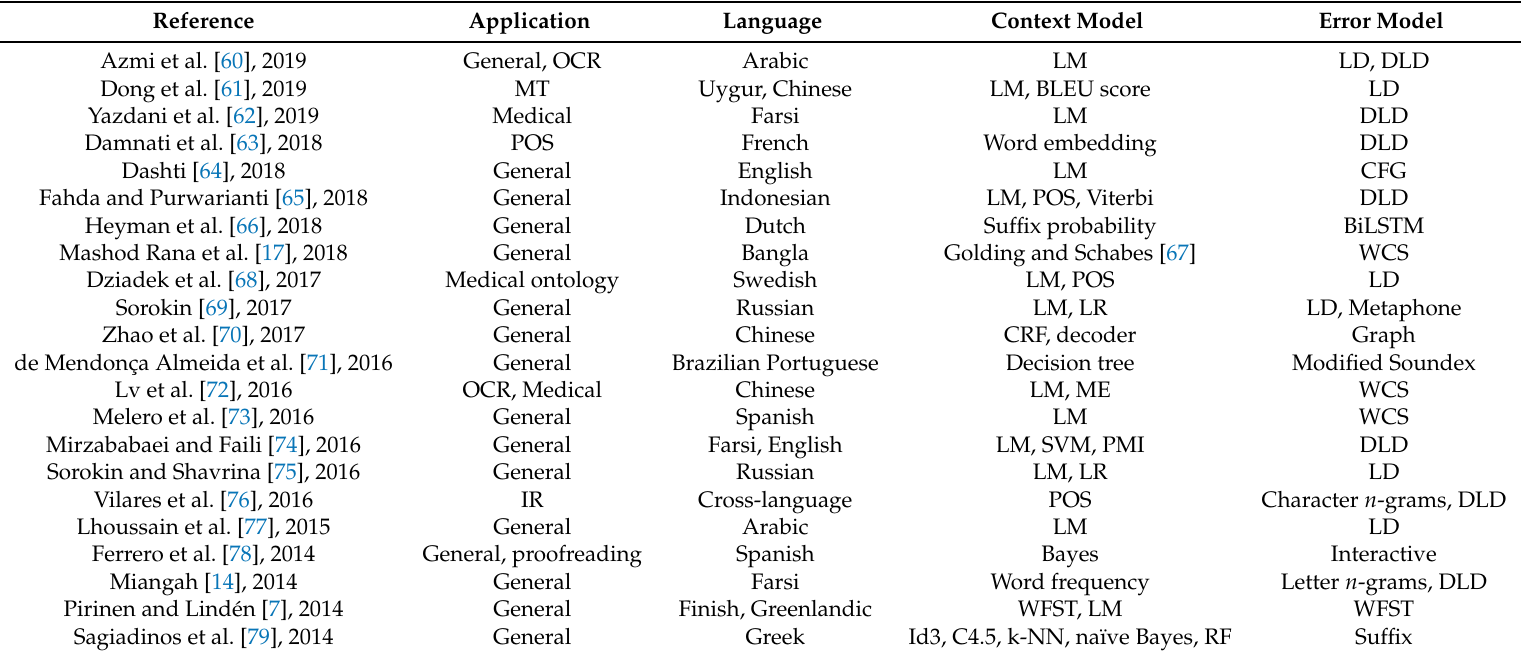
Table 3. Spelling correction systems with learning of context model—part